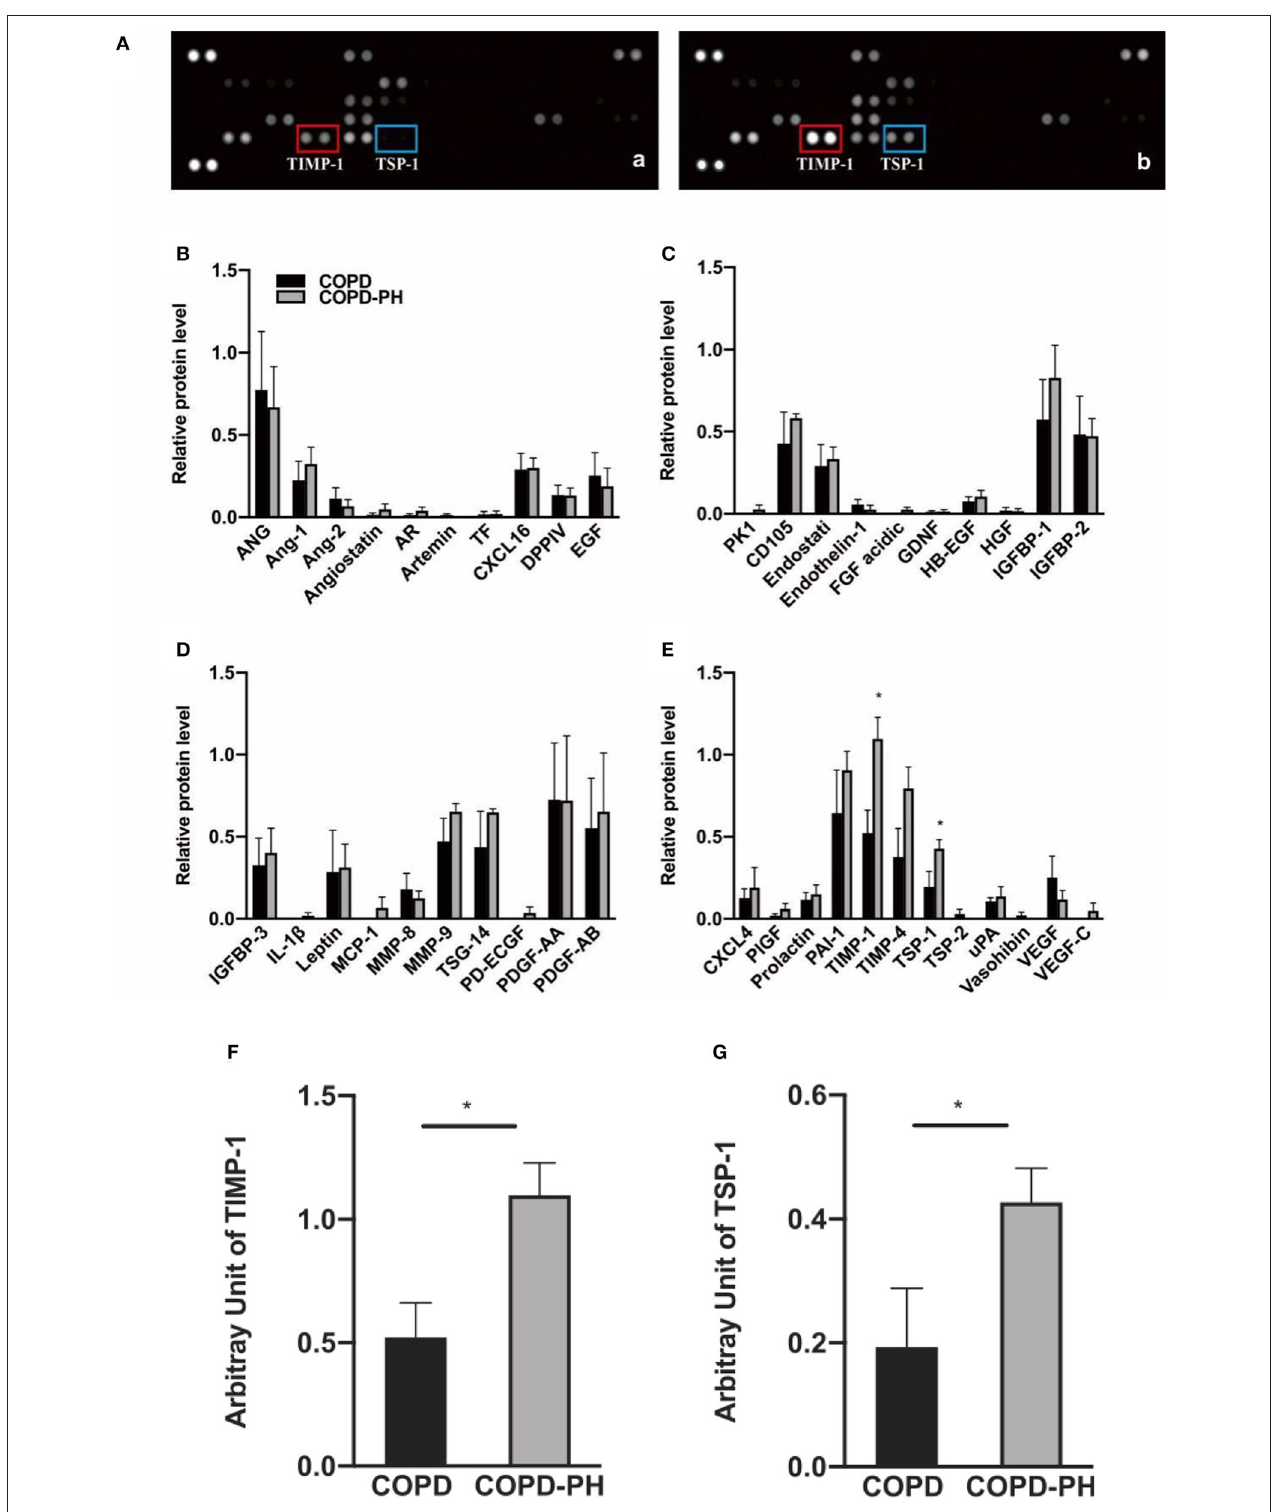
FIGURE 1 | Angiogenesis array data. (A) Representative image of angiogenesis array of the plasma from COPD patients without PH [COPD, (a)] and with PH [COPD-PH, (b)] array blots. The levels of angiogenic factors are determined based on their blotting intensity in duplicates. (B–E) Relative protein level of for angiogenesis-associated protein determined by angiogenesis assay (Data were normalized to three pairs of reference spots). (F,G) Based on two-sample independent Student’s t -test analysis, TIMP-1 and TSP-1 were significantly higher in COPD-PH than COPD group. Data were present as mean ± SEM ( n = 4). * P < 0.05 vs. COPD